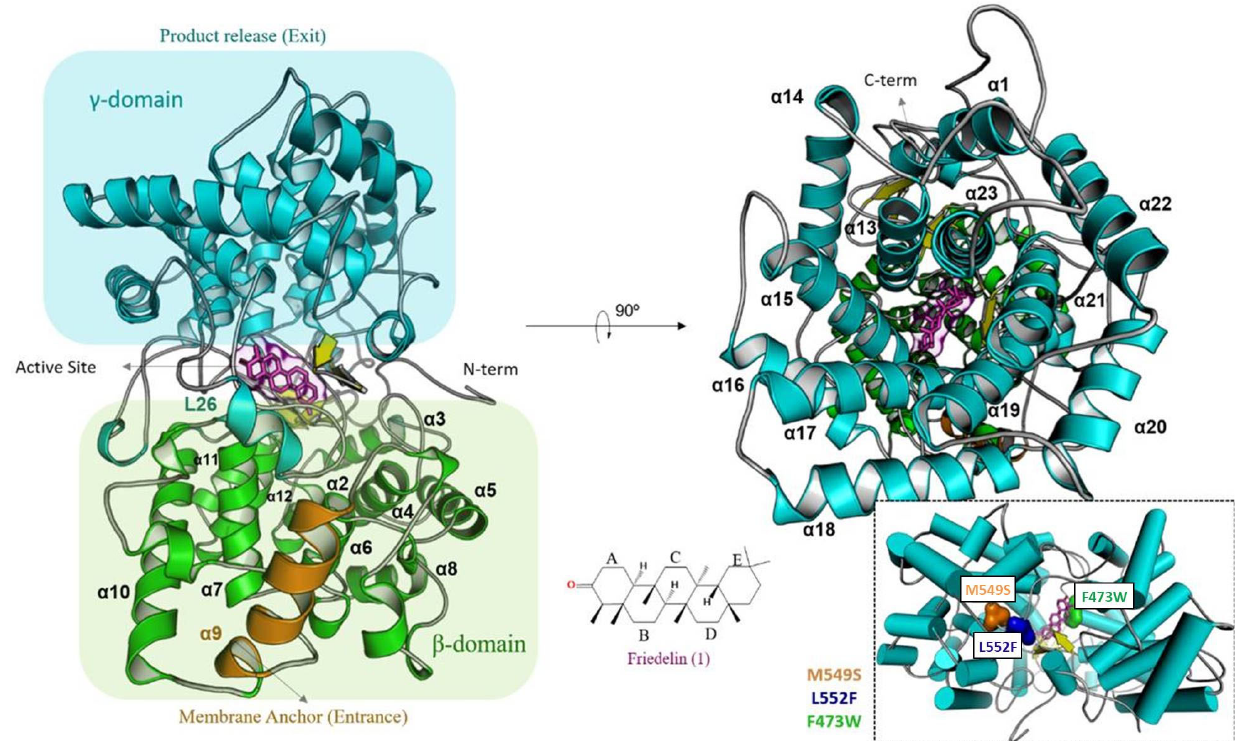
Figure 3. In silico model of the enzyme friedelin synthase from M. ilicifolia ( Mi FRS). Secondary structure representation shows the α / α domains known as βγ‐ protein. The α 9 helix approaches the lipid bilayer which sources the substrate. On the other side, the γ‐ domain processes and release the friedelin product. Horizontally to the N ‐ terminal is organized the active site, created in interface between γ and β domains. Specifically, flexible loops and three β‐ hairpins give motion and polarity for the substrate production. Mutations made are located in loop regions as follows: L23 (Phe473Trp), L26 (Leu552Phe) and (Met549Ser). Native amino acids overview is highlighted by surfaces in colors on their positions inside the folding.